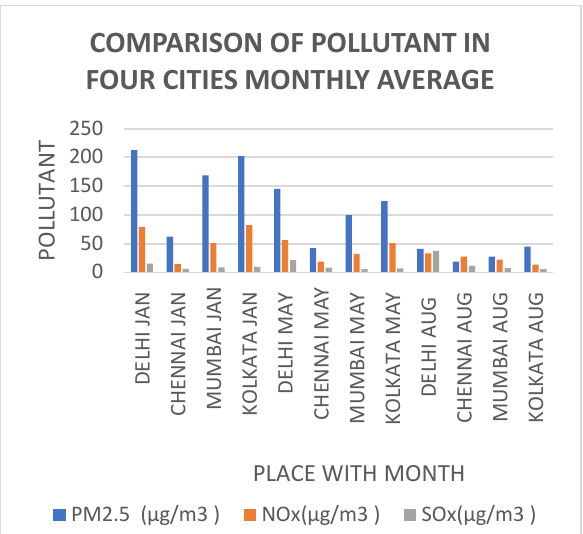
Figure 20. Comparison of seasonal variation in the Air quality of four different metropolitan cities for a monthly average (µg/m 3 ).